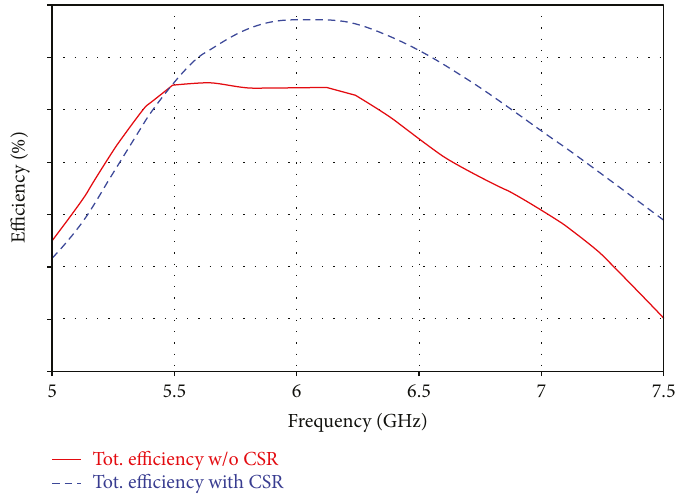
Figure 22: Simulated total e ffi ciency of a whole antenna system with and without MTM-CSR matrix